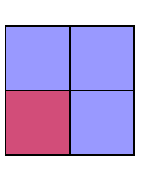
FIG. 7. An optimal classical strategy for the d = 2 Torpedo Game. Alice uses her bit of communication to indicate in which class of the partition that she finds herself. Classes are represented here by colors.